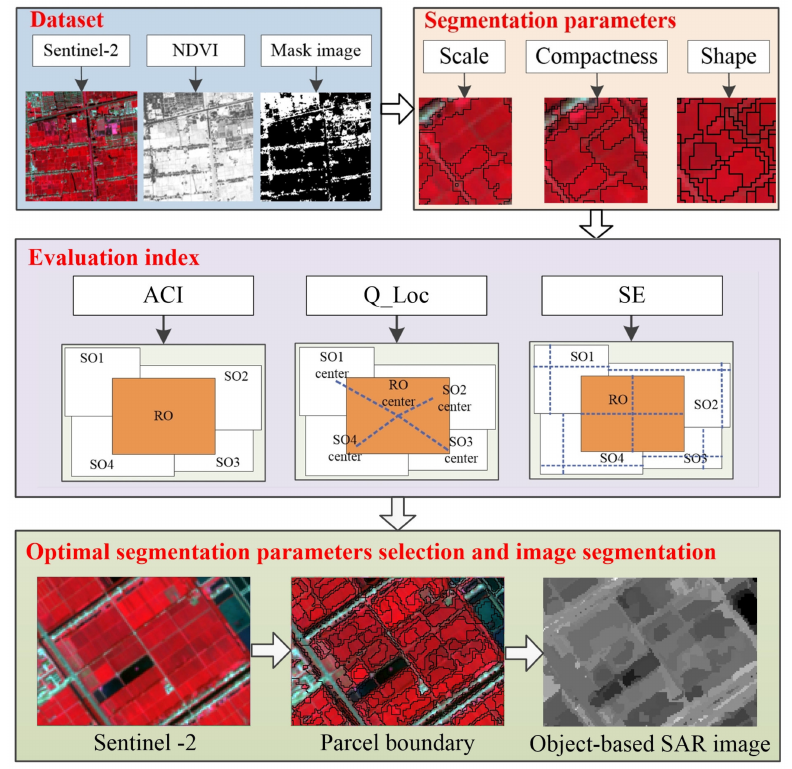
Figure 6. Overview of the multi-scale image segmentation for parcel boundary